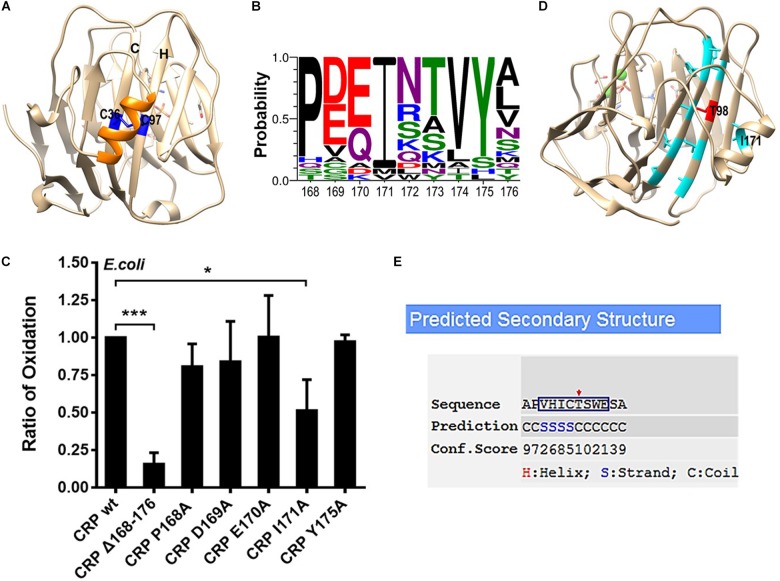
The efficient bonding of the intra-subunit disulfide depends on I171 within the covering helix. (A) The disulfide bond forming residues C36 and C97 in the subunit of CRP (PDB ID: 1B09) are colored as blue, while the covering helix a.a. 168–176 is colored as orange. (B) Conservation analysis of a.a. 168–176 of CRP from 21 species. P168, I171, and Y175 emerge as the most conserved residues. (C) CRP wildtype (wt) or mutants with a signal peptide of ALP were expressed in E. coli. The correct bonding of the intra-subunit disulfide bond in secreted CRP was determined by immunoblotting with 3H12 mAb (7). In addition to mutant lacking the entire covering helix, only I171A mutant significantly impaired the bonding of the intra-subunit disulfide. (D) Hydrophobic amino acids on strands C and H are colored as light blue while the hydrophilic T98 as red. The hydrophobic I171 points its side-chain to T98 directly. (E) The β-strand forming propensity of a.a. 94–101 (square), which constitutes strand H in the crystal structure of CRP, was calculated by I-TASSER (21, 22). T98 (red arrow) appears to be a strand-breaking residue being covered by I171. *p < 0.05; ***p < 0.001.